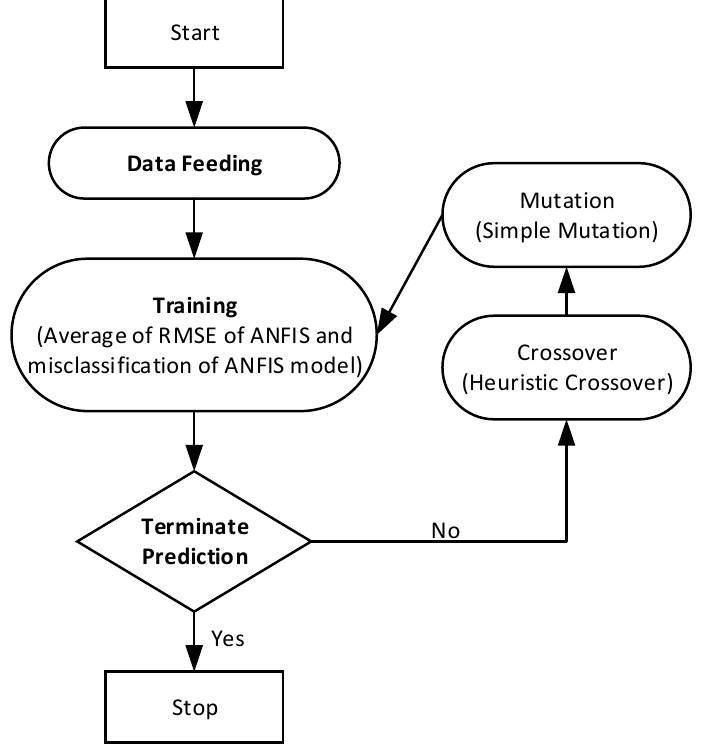
Figure 1. Optimization of ANFIS model when implemented with GA.